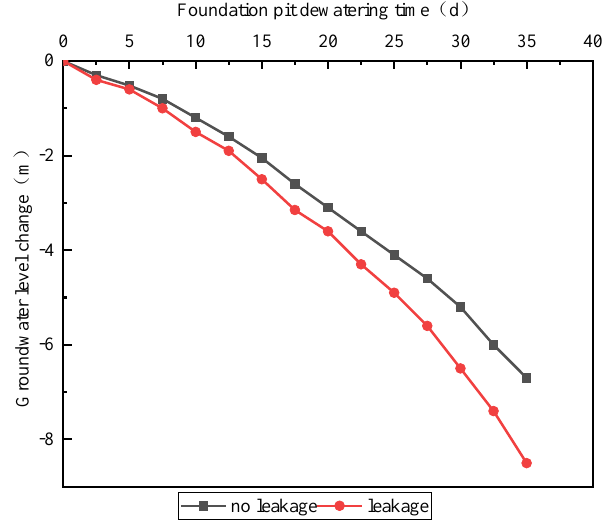
Figure 11. Variation curve of groundwater level of the envelope with and without leakage.